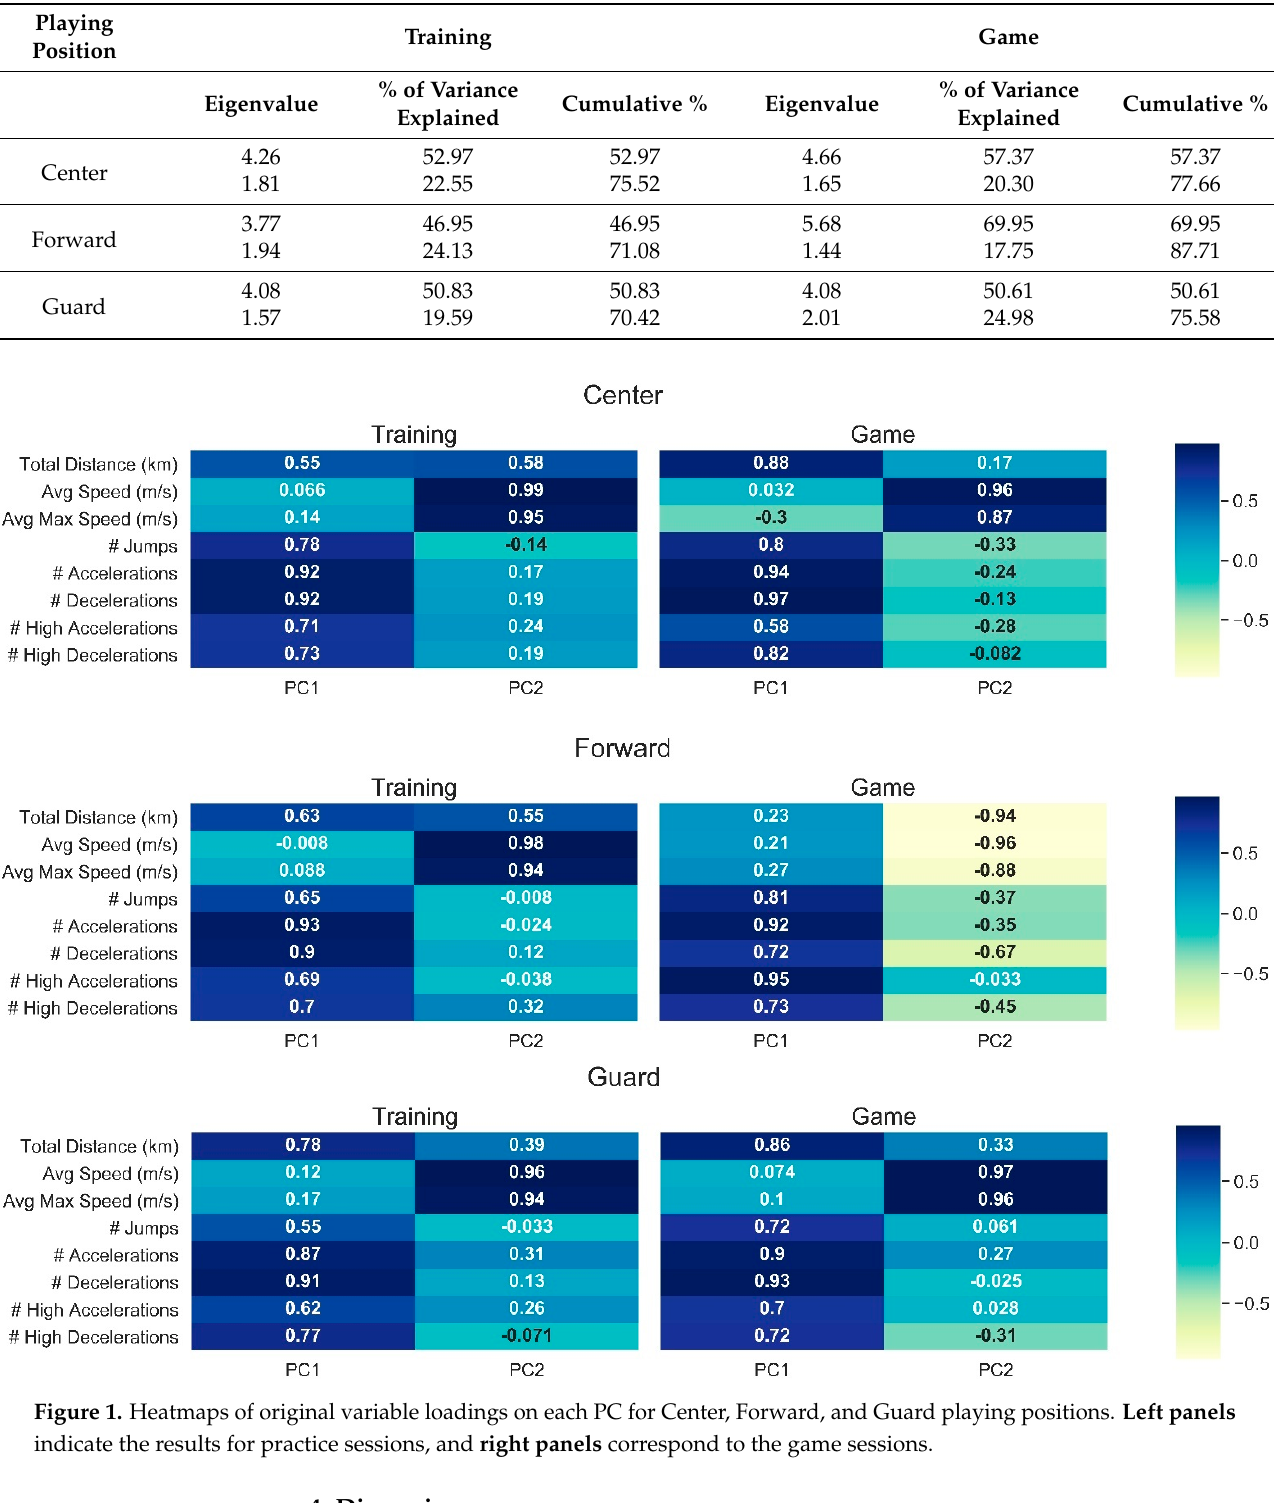
Table 4. Eigenvalues and explained variance of preserved principle components (PCs) (eigenvalue greater than one) for external training load factors in the basketball team for each playing position in the training and game sessions.